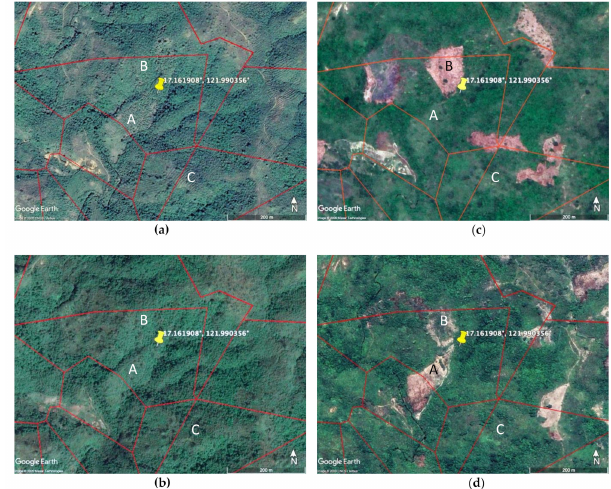
Figure 10. Actual changes in vegetation cover observed on ( a ) 2 March 2014; ( b ) 15 January 2016; ( c ) 5 April 2016; and ( d ) 11 July 2019 for a segment of the area within Site 1 (Pin location: 17.161908 ◦ , 121.990356 ◦ ) as observed using very high-resolution (VHR) RGB data accessed through Google Earth